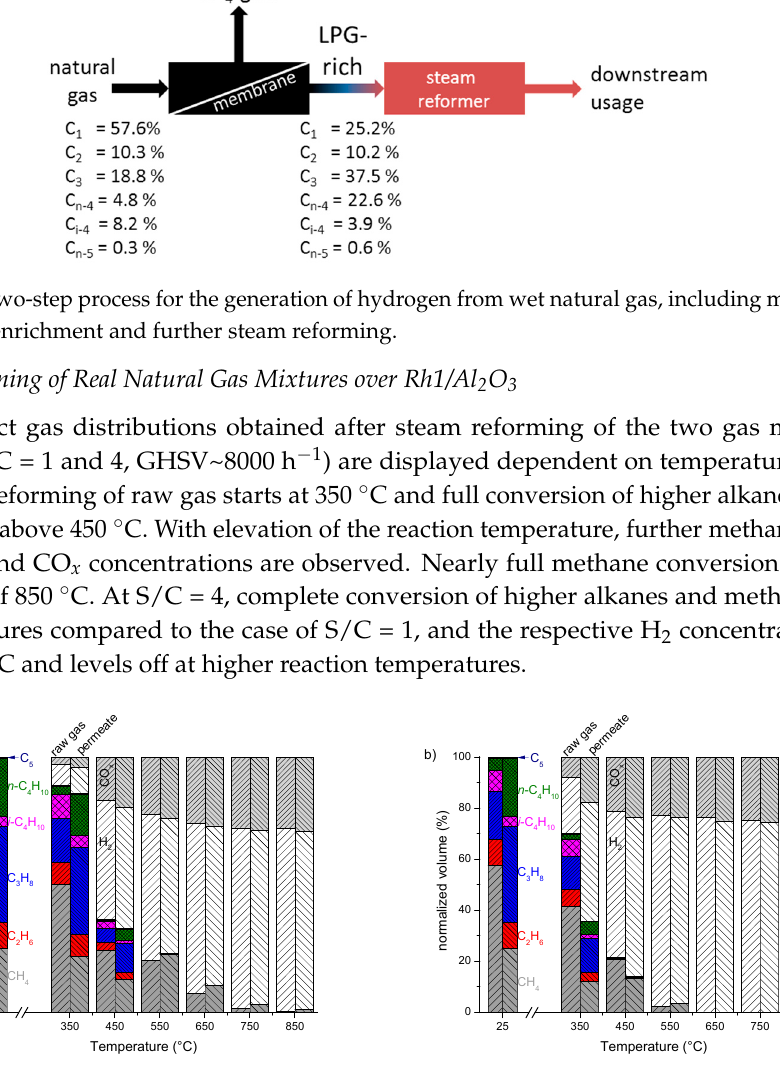
Figure 4. Volumetric gas contents of raw natural gas and LPG-enriched permeate natural gas from membrane pre-separation and after steam reforming over Rh1/Al 2 O 3 at ( a ) S/C ratio of 1 and ( b ) S/C ratio of 4.